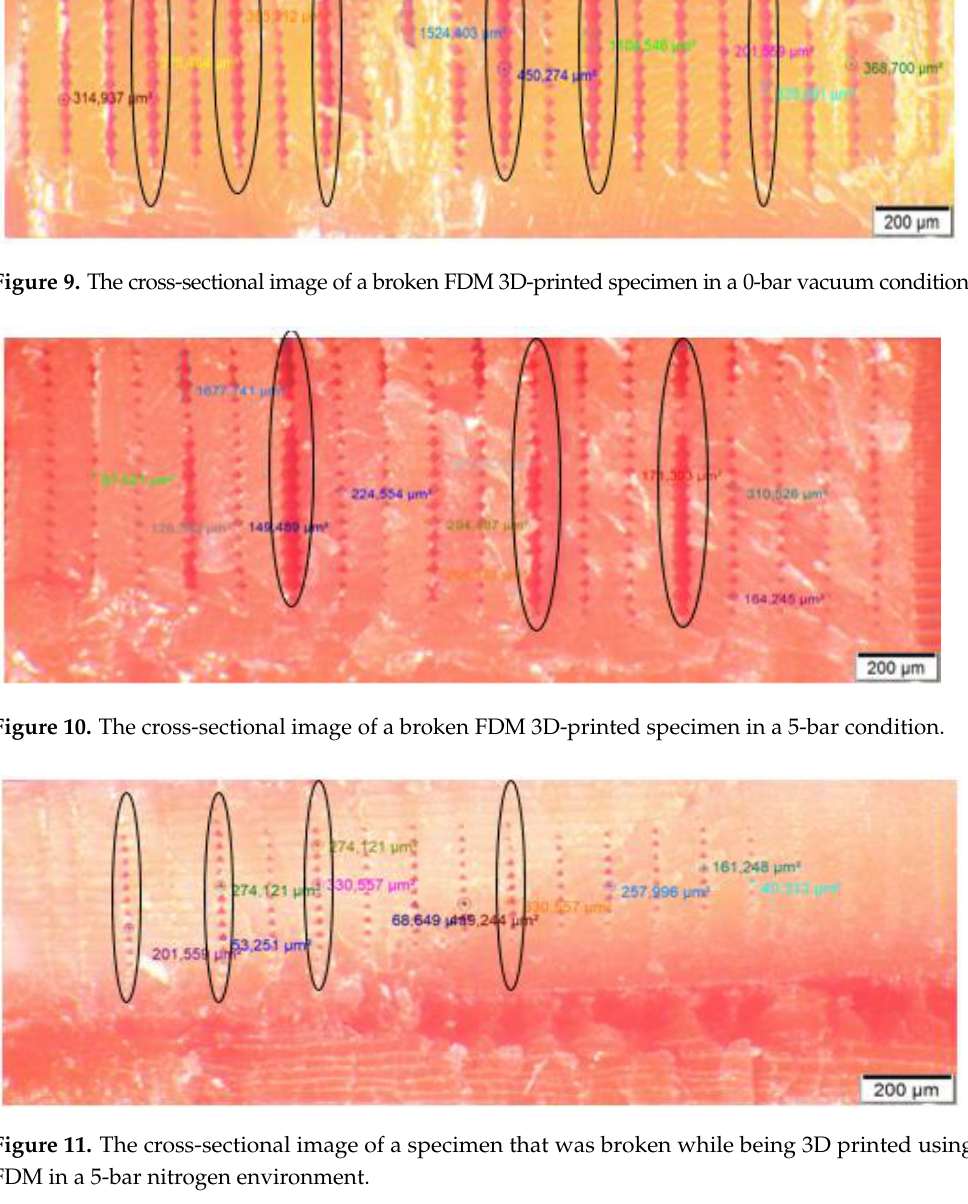
Table 1. Averaged area of voids that were captured during microscopy.